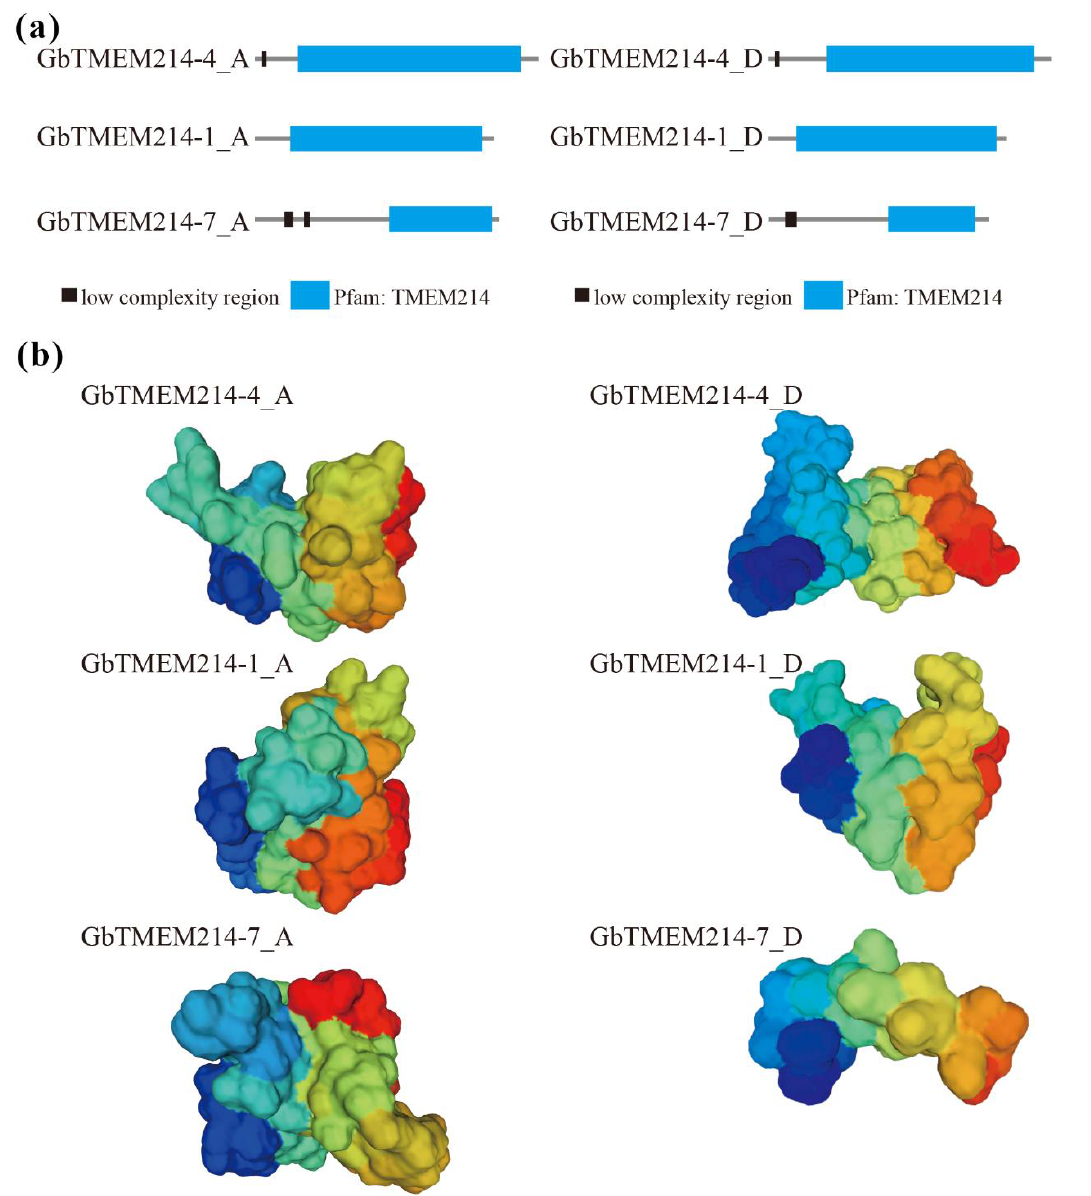
Figure 3. The protein structure of GbTMEM214s. ( a ) Protein sequence of GbTMEM214s in D-genome were analyzed with the Simple Modular Architecture Research Tool (SMART, http://smart.embl-heidelberg.de/ accessed on 13 May 2022). The structural models automatically generated with the website were recolored to highlight each domain. The low complexity region and TMEM214 domain were represented by black and blue boxes, respectively. ( b ) 3D structural models of GbTMEM214s D-genome. Homology modeling of protein structures was applied to construct the 3D structural models using the SWISS-MODEL web server (https://swissmodel.expasy.org/ accessed on 13 May 2022). The optimal PDB modeling templates were selected according to the Global Model Quality Estimate (GMQE) value (Tables S1 and S2).